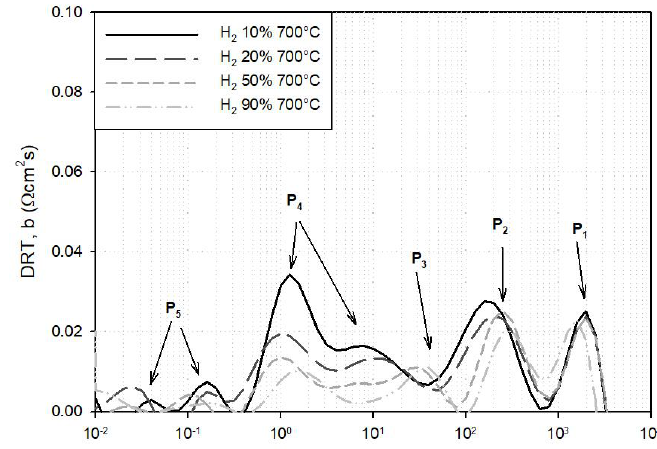
Figure A2. Effect of hydrogen variation on the DRT spectra.